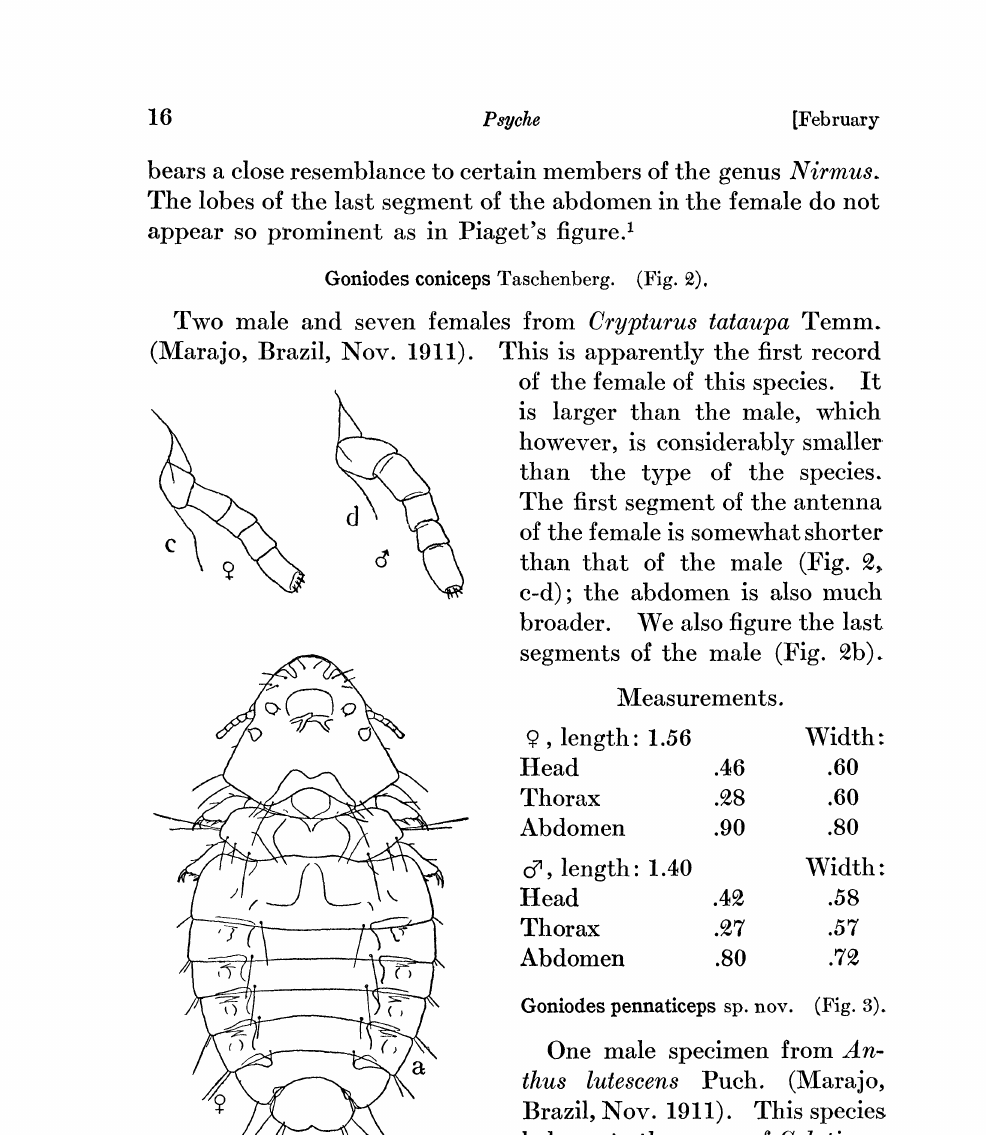
Fig. 2. Goniodes coniceps